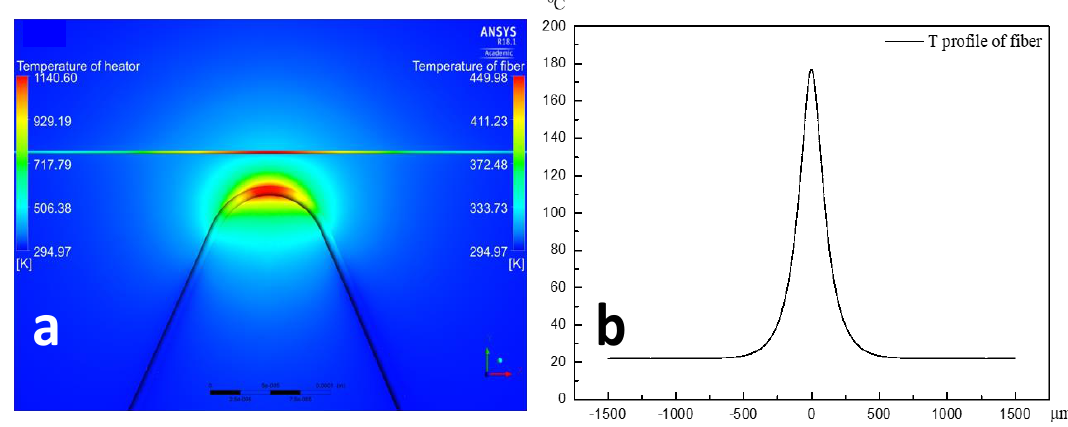
Figure 3. Temperature profile of the W wire heater and the polyethylene microfiber (MF) from an ANSYS/FLUENT simulation. ( a ) Temperature map of the heater and the MF. ( b ) Plot of the MF temperature profile. The maximum temperature reaches 450 K (180 °C). Adapted from reference [3] supplementary information.